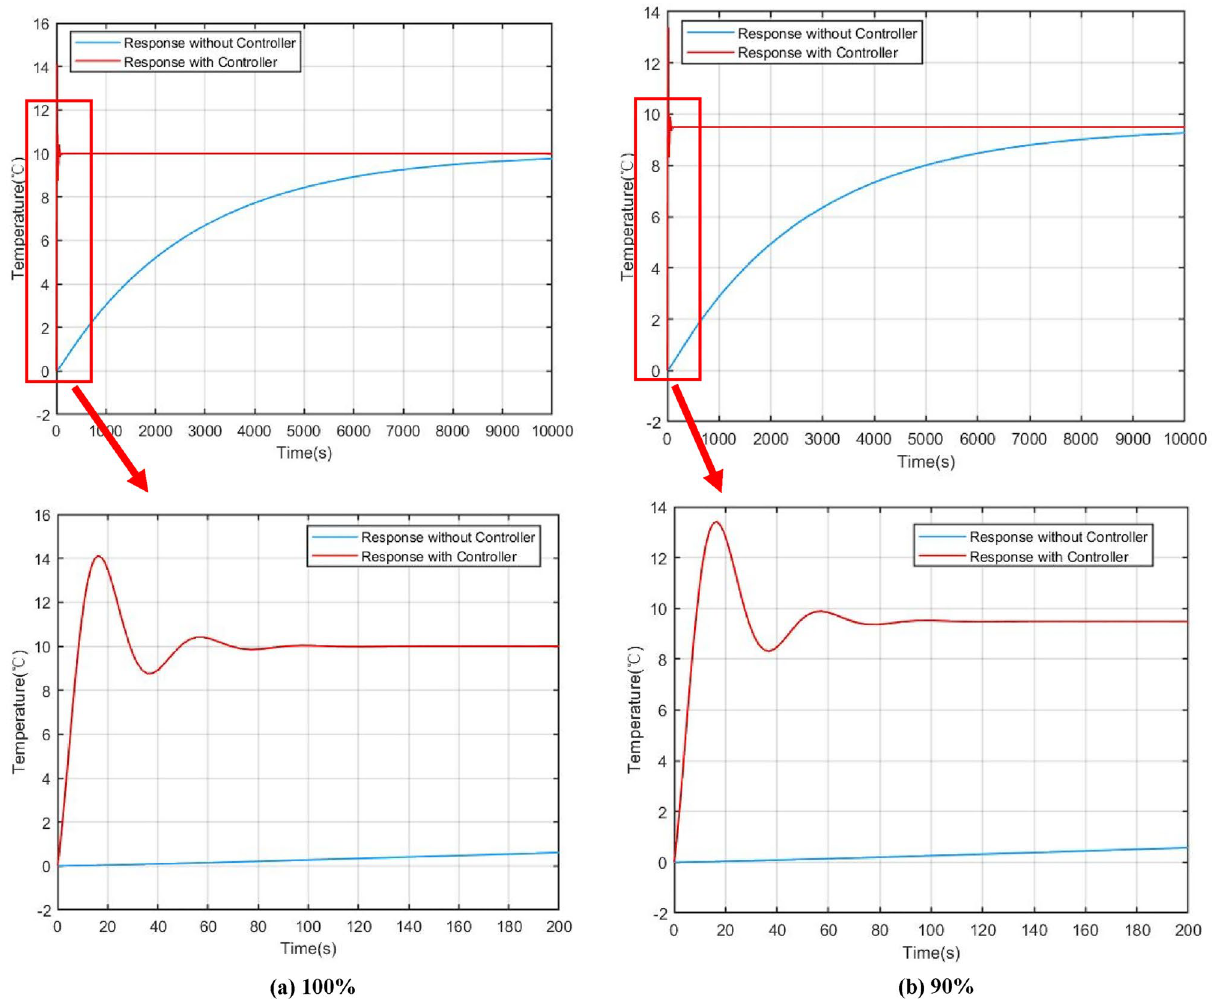
Figure 10. Comparison of core temperature responses with and without controller, ( a ) 100%, ( b ) 90%, ( c )